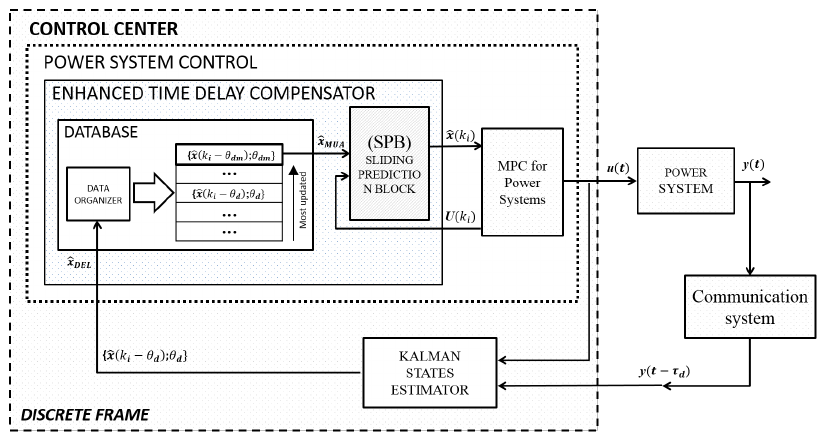
Figure 5. ETDC + Model Predictive Control (MPC) scheme for time delayed Power Systems.